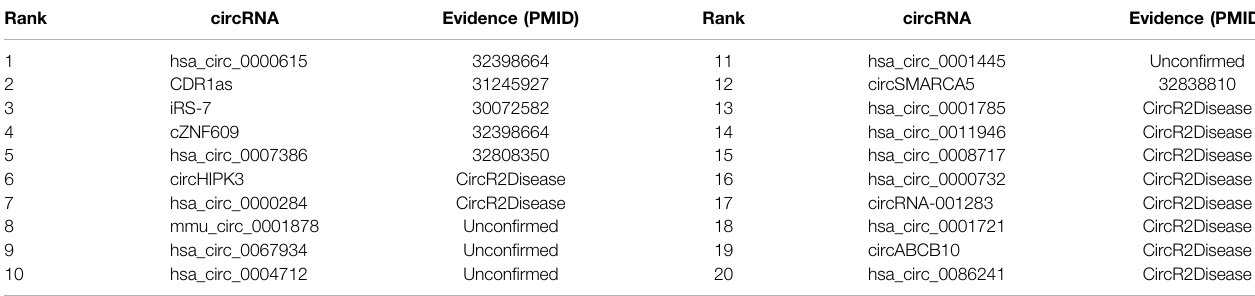
TABLE 4 | The top 20 breast cancer-related candidate circRNA.